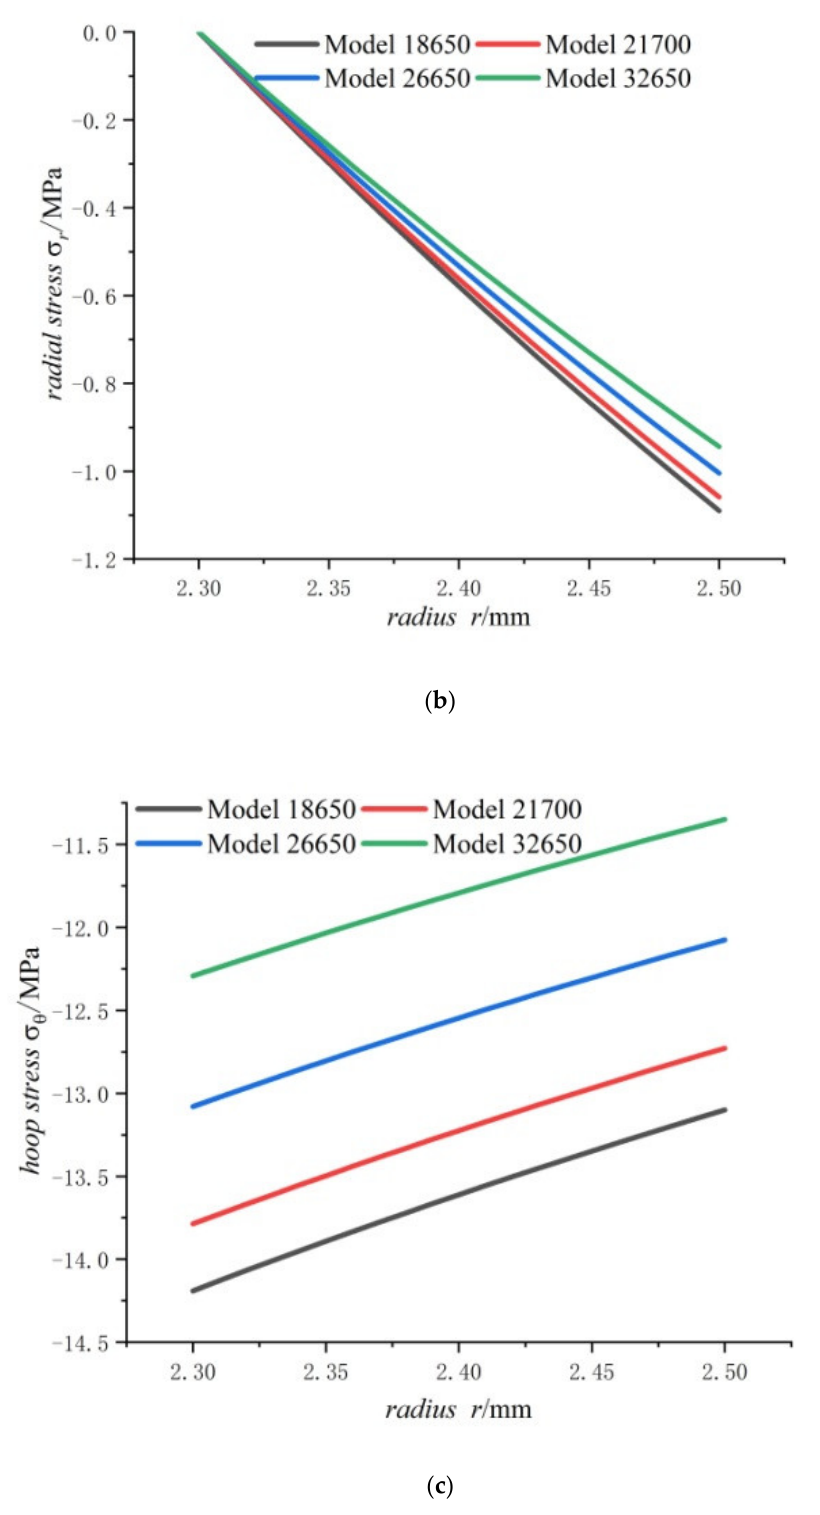
Figure 7. Displacements and stresses of the steel core of four types of lithium-ion power batteries in a fully charged state: ( a ) displacements; ( b ) radial stresses; ( c ) hoop stresses.